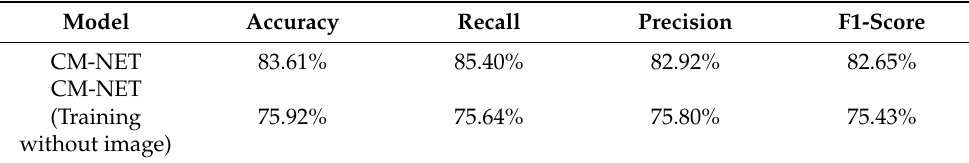
Table 2. CM-NET performance on